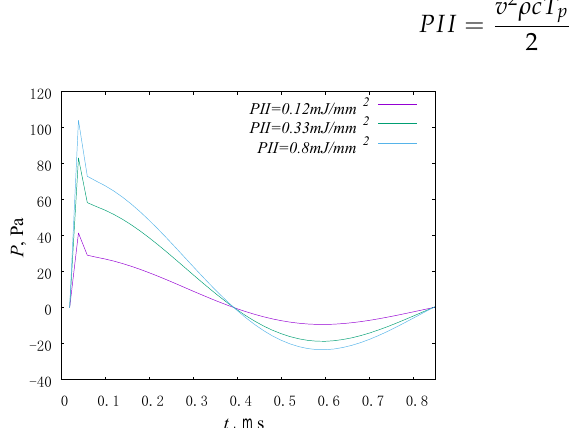
Figure 6. Plots of the pressure profile of shock wave with a different energy flux density. The parameter of “normalized pulse length” was determined from the graphs of pressure versus the time of